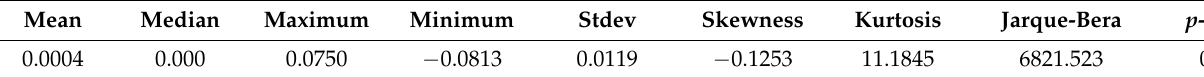
Table 1. Jarque-Bera statistics for data selected.